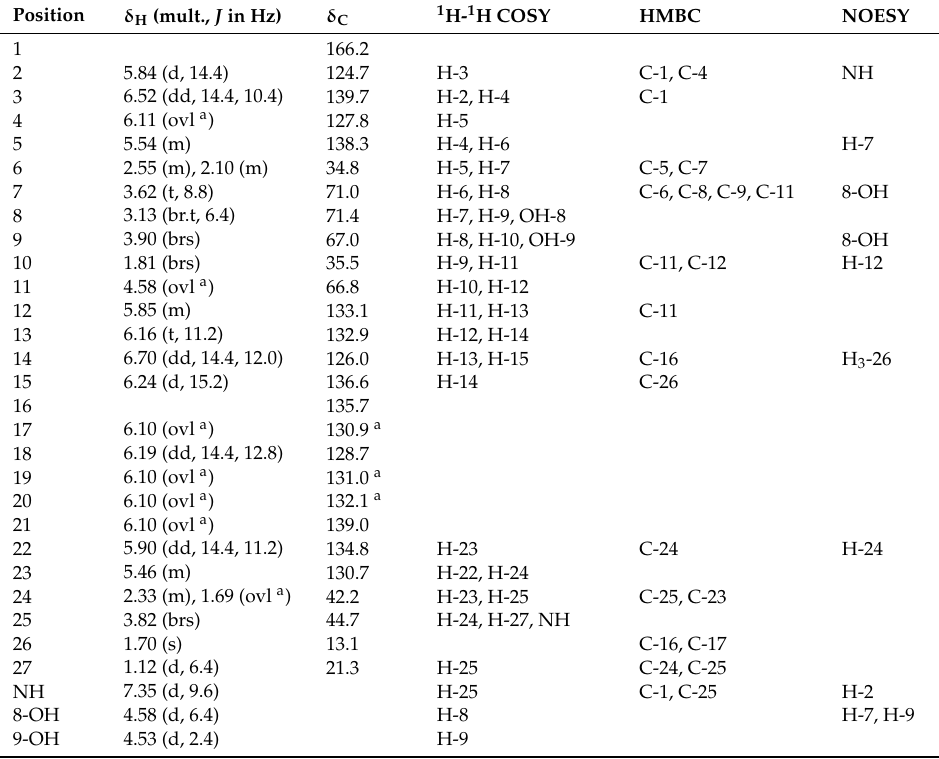
Table 2. NMR data of pretilactam ( 1 ).